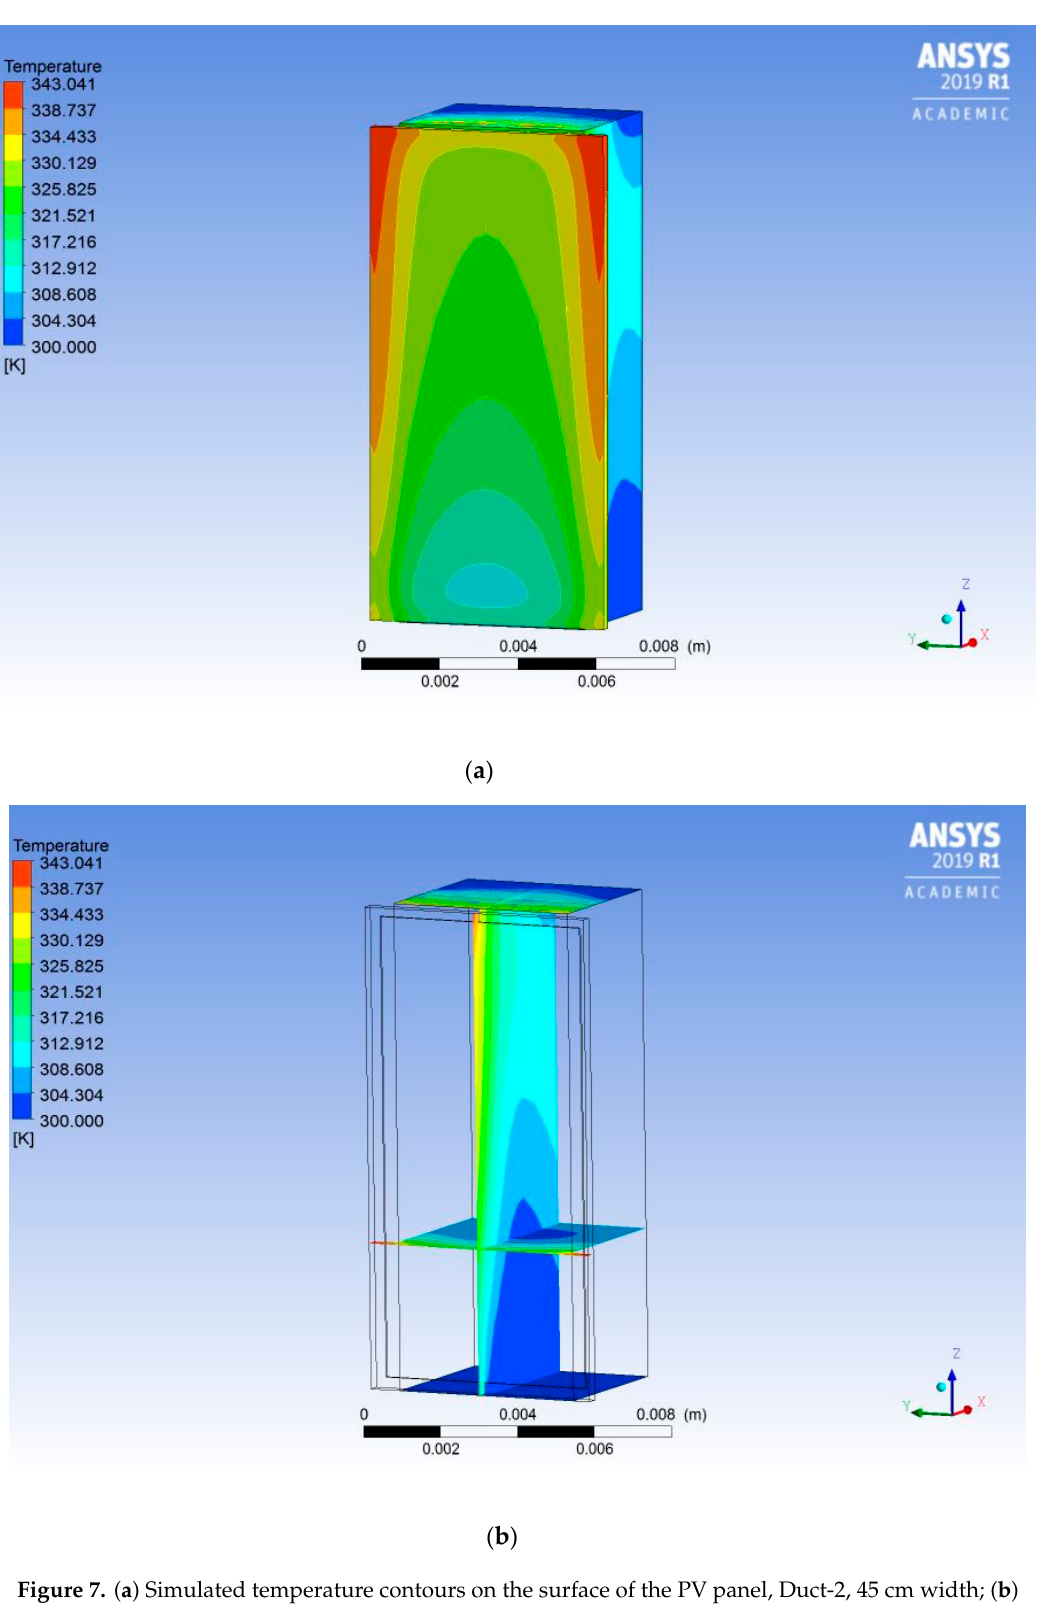
Figure 6. ( a ) Comparison between the temperature change from the experimental and computational fluid dynamics (CFD)-simulated results; ( b ) comparison between the cooling effect from the experimental and CFD-simulated results.